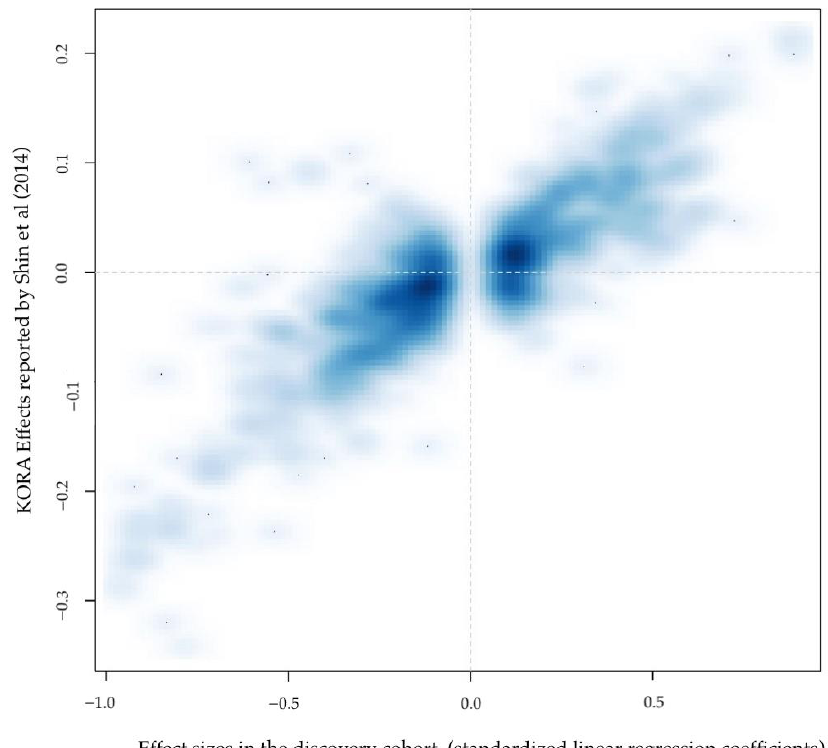
Figure 2. Comparison of the effects of association observed in the NIHR BioResource discovery cohort versus the effects previously reported in the KORA cohort [11].